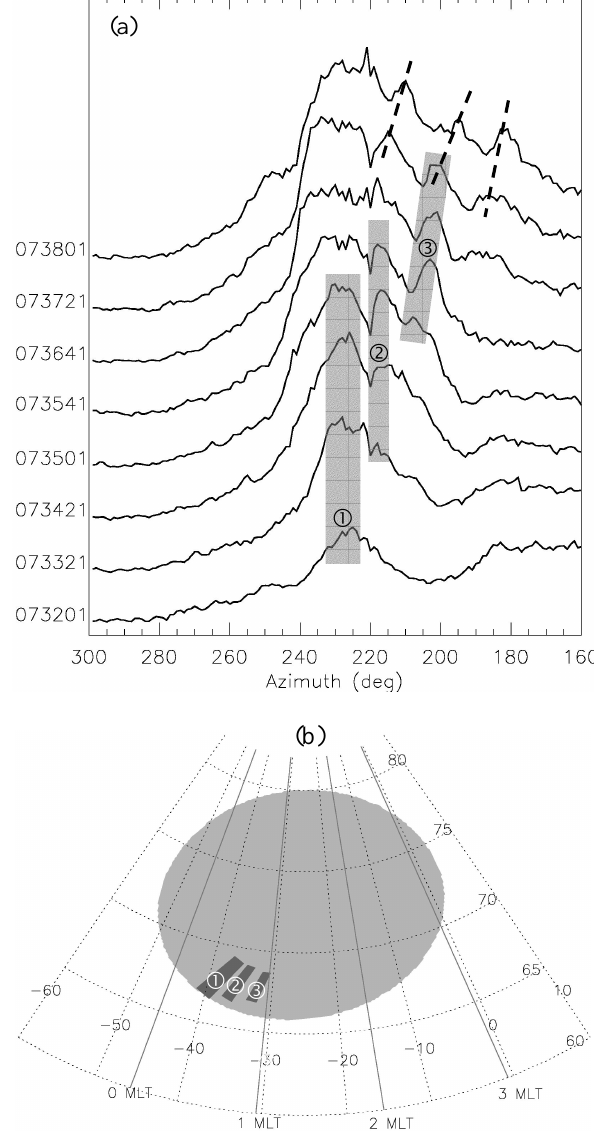
Figure 7 The top two panels show the time plots of the latitude and longitude of the NORSTAR image Figure 8 (a) The radially-integrated 630 nm emission intensity versus azimuth angle observed by NASI Figure 8 (a) The radially-integrated 630 nm emission intensity versus azimuth angle observed by NASI Fig. 7. The top two panels show the time plots of the latitude and Fig. 8. (a) The radially-integrated 630nm emission intensity versus pixels where the 630.0 nm intensity is within 5% of the maximum. The third panel shows the maximum during the first pseudobreakup interval. The observation time in UT is labeled on the left of each curve. during the first pseudobreakup interval. The observation time in UT is labeled on the left of each curve. longitude of the NORSTAR image pixels where the 630.0nm in- azimuth angle observed by NASI during the first pseudobreakup intensity versus time. tensity is within 5% of the maximum. The third panel shows the interval. The observation time in UT is labeled on the left of each Numbered gray bands indicate several intensified patches. (b) The approximate geomagnetic position of Numbered gray bands indicate several intensified patches. (b) The approximate geomagnetic position of maximum intensity versus time. curve. Numbered gray bands indicate several intensified patches. the discrete patches (dark boxes). The gray circle indicates the FoV of the NASI at Rankin Inlet. the discrete patches (dark boxes). The gray circle indicates the FoV of the NASI at Rankin Inlet. (b) The approximate geomagnetic position of the discrete patches (dark boxes). The gray circle indicates the FoV of the NASI at Rankin